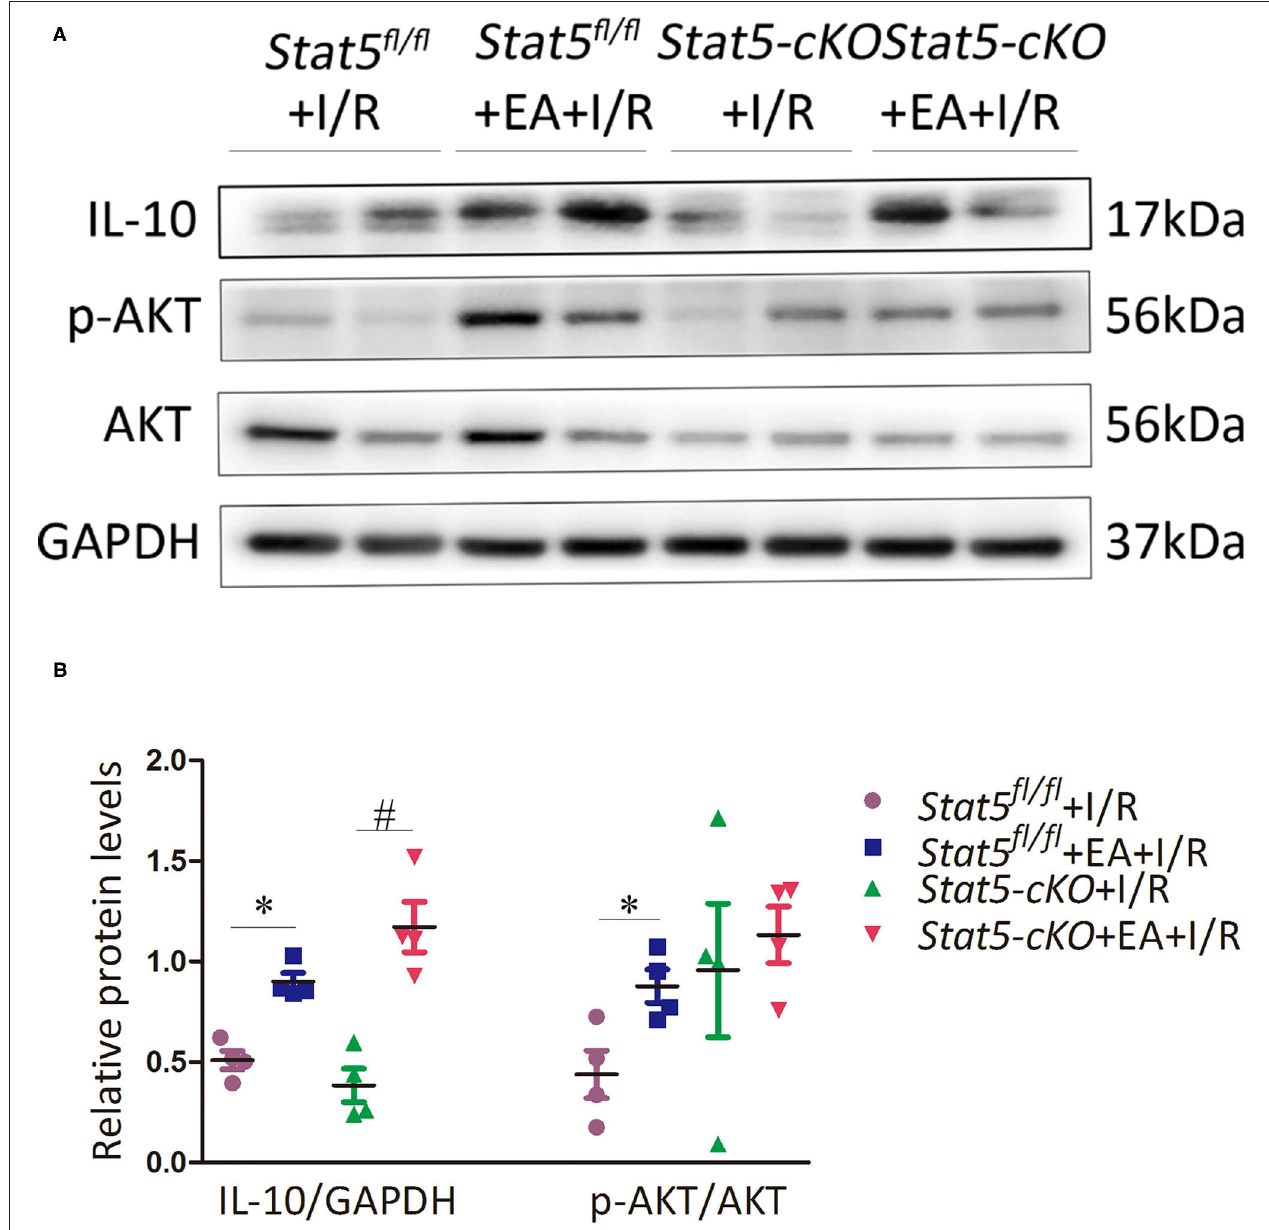
FIGURE 8 | The expression of survival signaling-related proteins. (A,B) Western blotting was used to detect the levels of IL-10, p-AKT, and AKT in each group. Data are presented as means ± SEM of more than three independent experiments. * P < 0.05 compared with the Stat5 fl / fl + I/R group; # P < 0.05 compared with the Stat5- cKO + I/R group. Data were analyzed by two-way ANOVA with Bonferroni’s multiple comparison test, n =